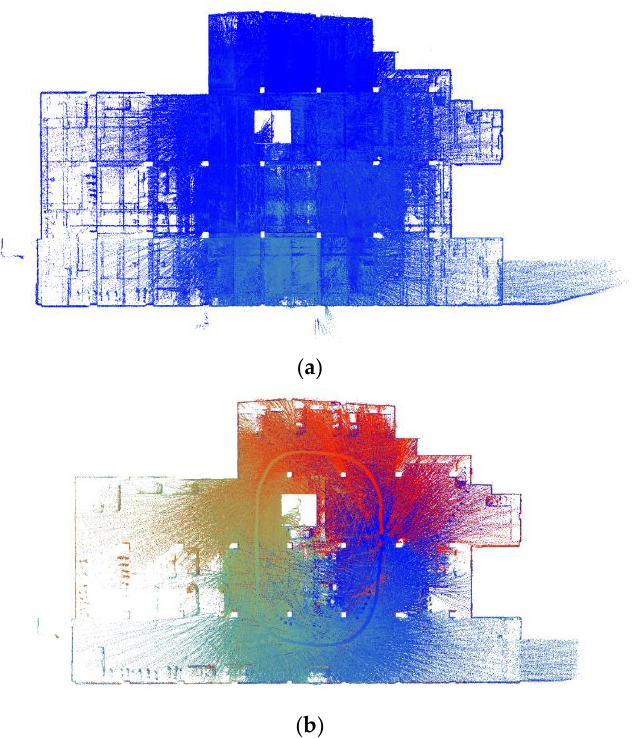
Figure 7. Point cloud and scanning trajectory of calibration data. ( a ) Colored by SLAM condition. ( b ) Colored by scanning time.